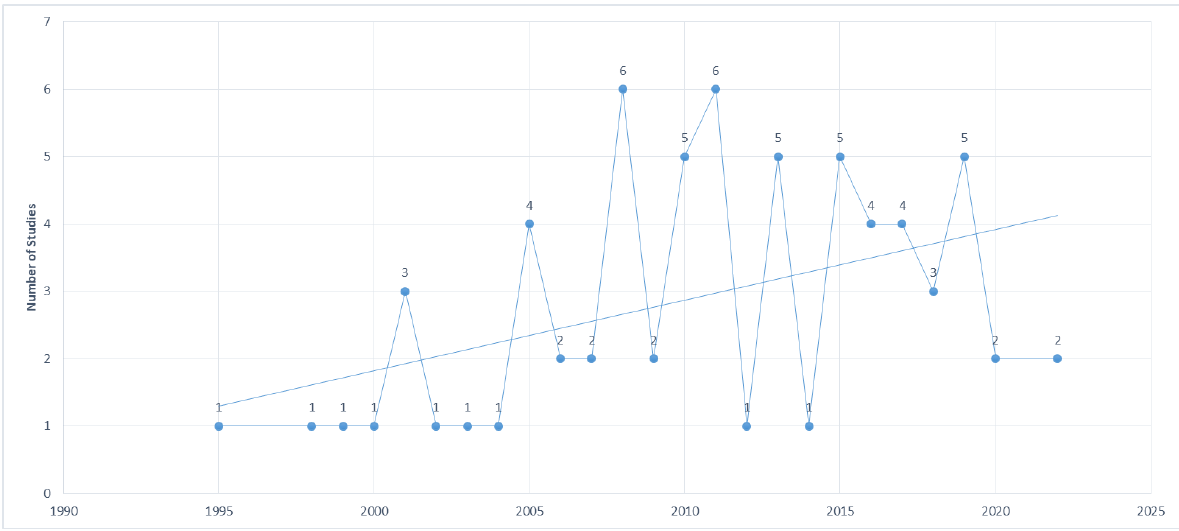
Figure 3. Number of studies across the